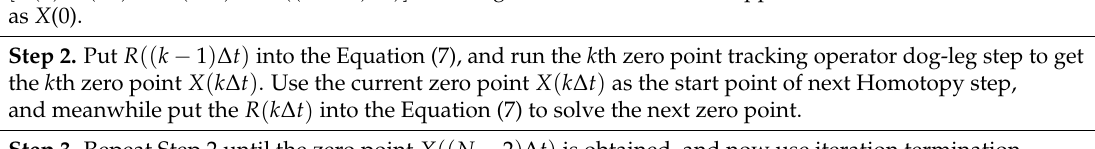
Table 1. Steps of the improved homotopy method.